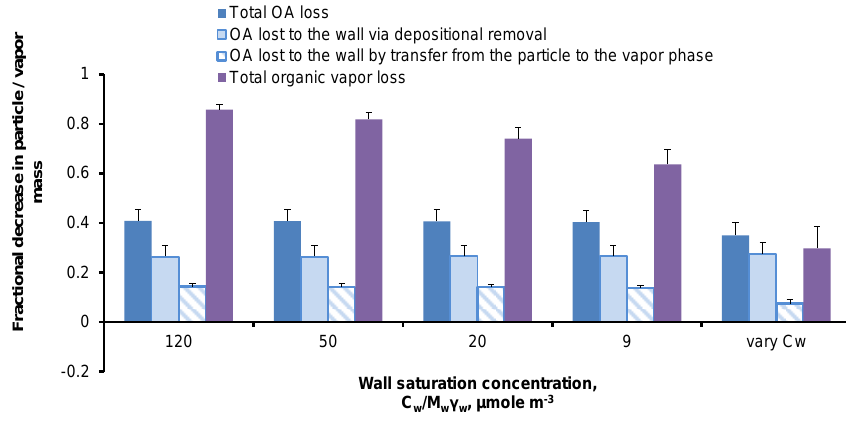
Figure 8. The organic species mass budgets for the base-assumption simulations ( C w /M w γ w of 120µmolem − 3 ) and three other sensitivity simulations using lower wall saturation concentration ( C w /M w γ w of 50, 20 and 9µmolem − 3 ) and varying C w /M w γ w (adapted from Zhang et al., 2015). All other variables as in Fig. 3b.